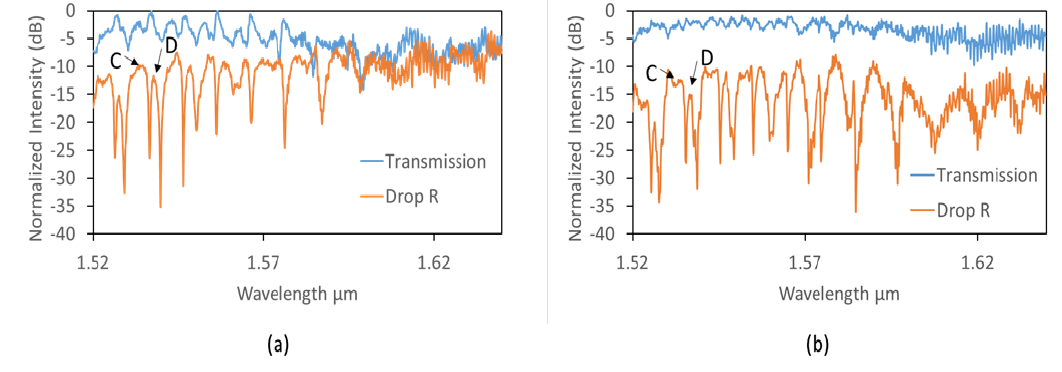
Figure 9. Experimental ( a ) transmission and Drop R for a 200-nm gap; ( b ) for a 300-nm gap.